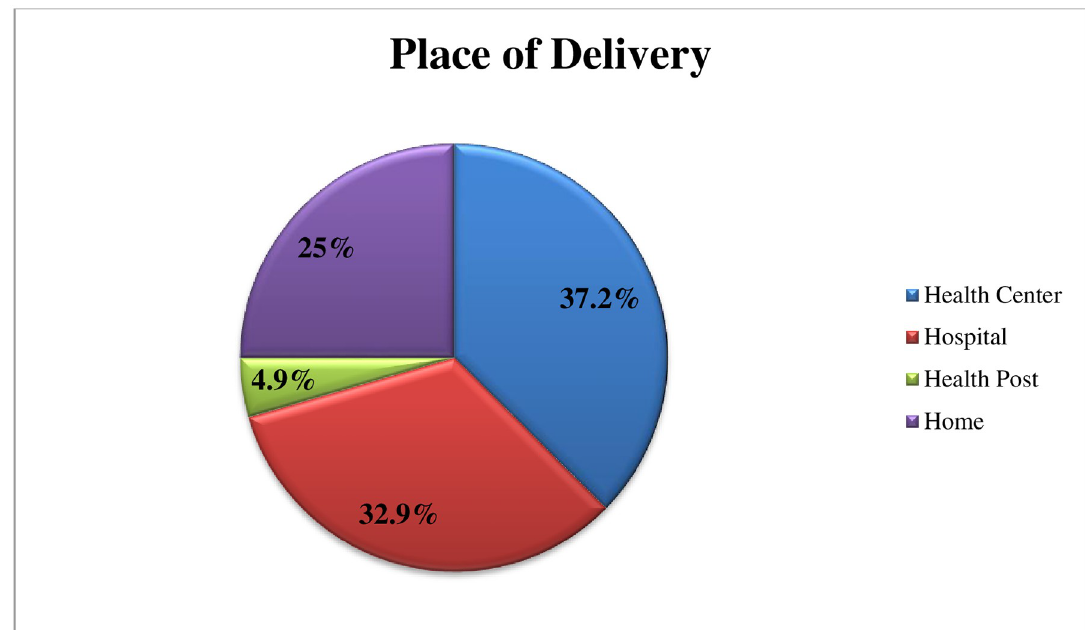
Fig 1. Place of delivery of the wife for current baby in the study of to assess knowledge towards breastfeeding in the Gurage zone, southern Ethiopia.